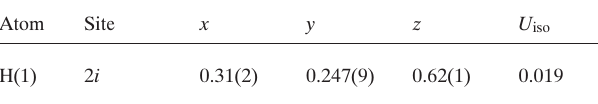
Table 2. Atomic coordinates and displacement parameters (in Å 2 )